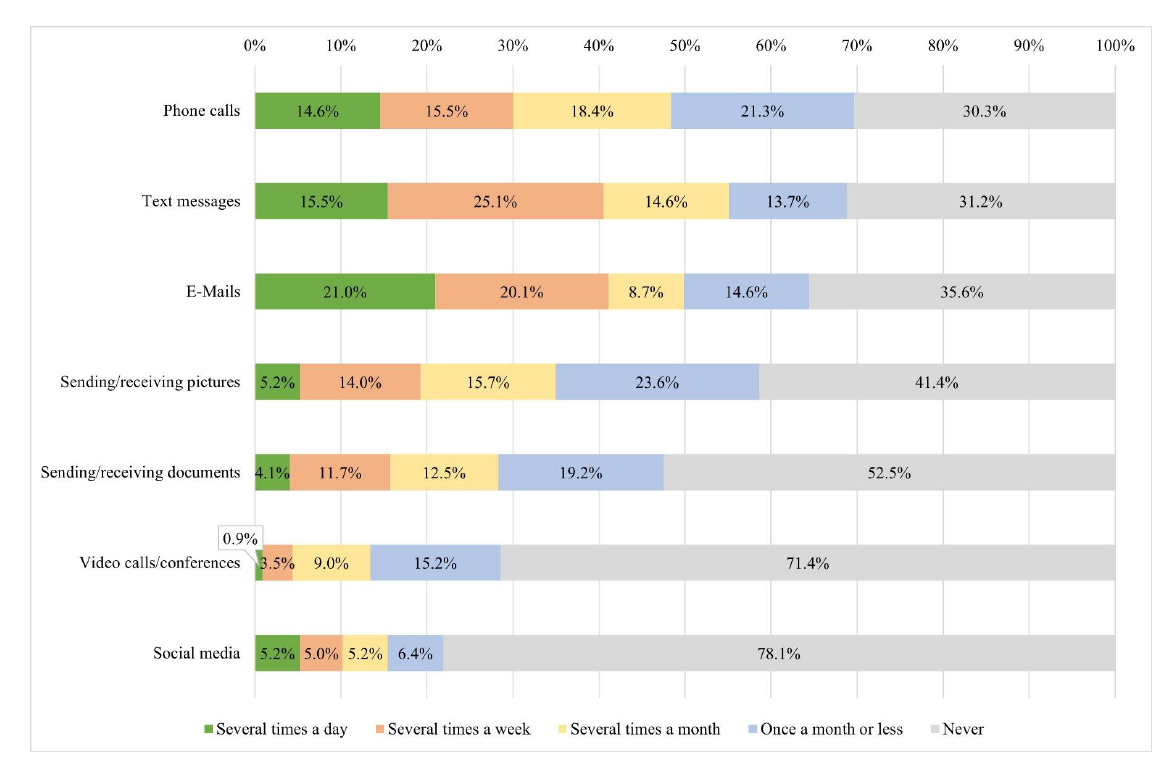
Figure A1. Communication Channels. Int. J. Environ. Res. Public Health 2022 , 19 , x FOR PEER REVIEW